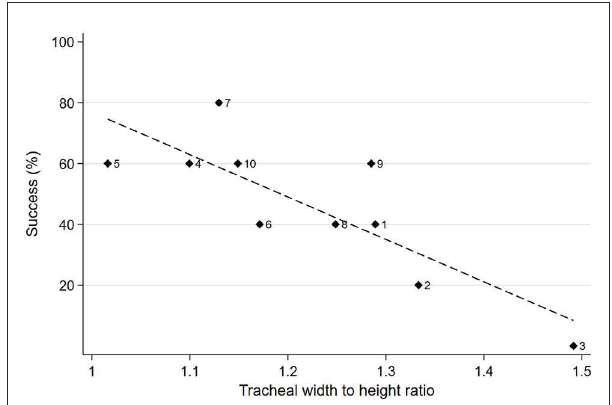
FIGURE3 Scatterplot of percent of successful airway sealing for all tubes by lateral to dorsoventral tracheal ratio with cadaver dog ID next to diamond markers, with line of best fit.